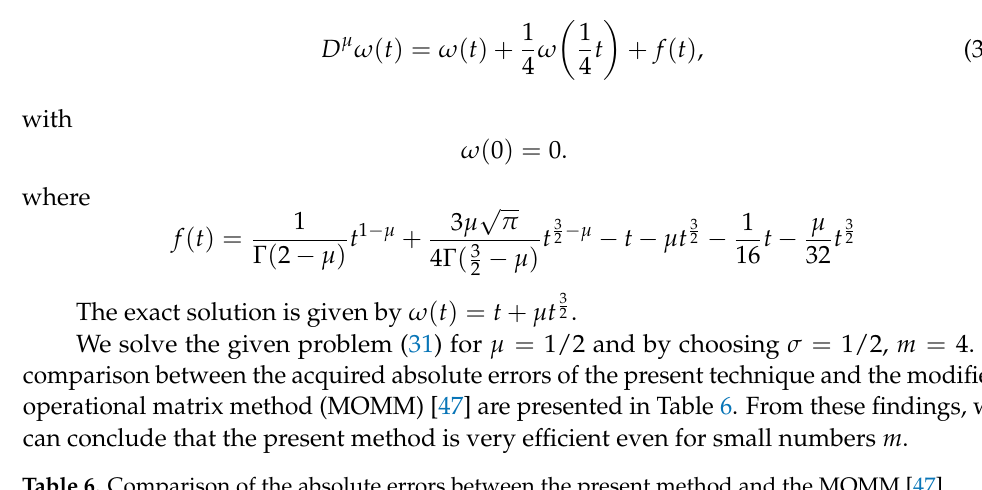
Table 6. Comparison of the absolute errors between the present method and the MOMM [47]. t Present Method for m = 4, σ = 1/2 MOMM for n = 20